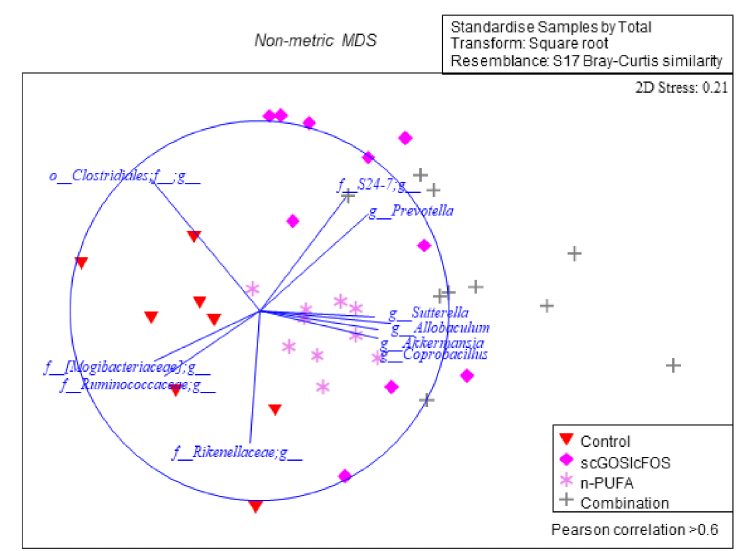
Figure 3. Visual of the non-multi-dimensional scaling (nMDS) plot depicting caecum content microbial community structures between control and dietary mice samples. A significant microbial community structure was observed between the control mice and the three dietary treatments. For statistical details, reference the analysis of similarity (ANOSIM) calculations in Table 1. Identified taxa with Pearson’s correlation (>0.6) were strongly associated with either the control or dietary